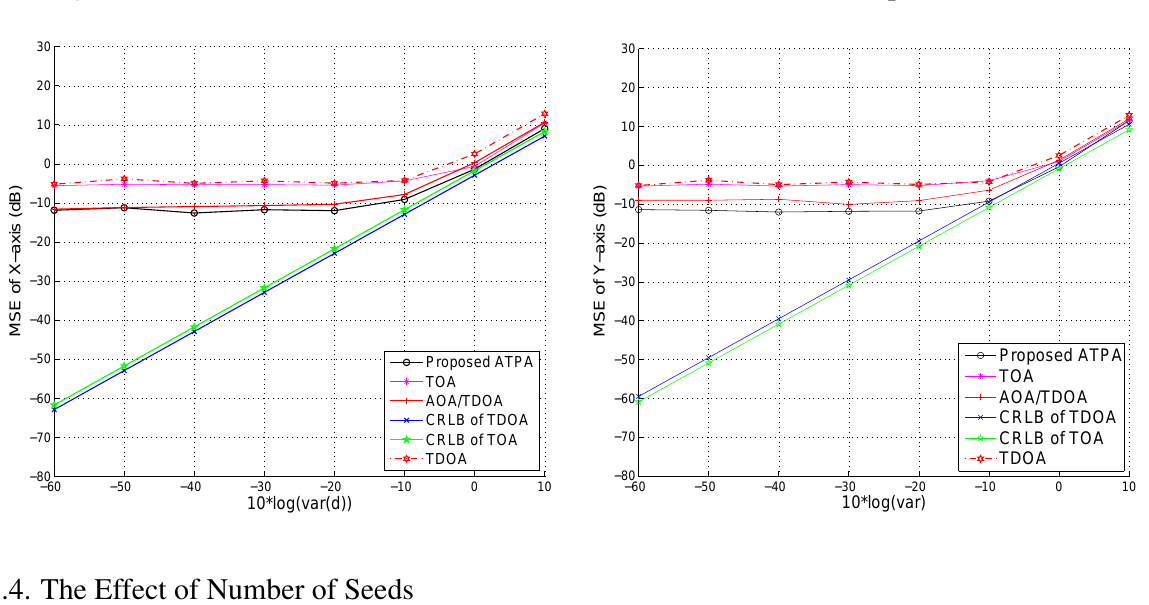
Figure 11. The effect of measurement noise of distance estimation on position